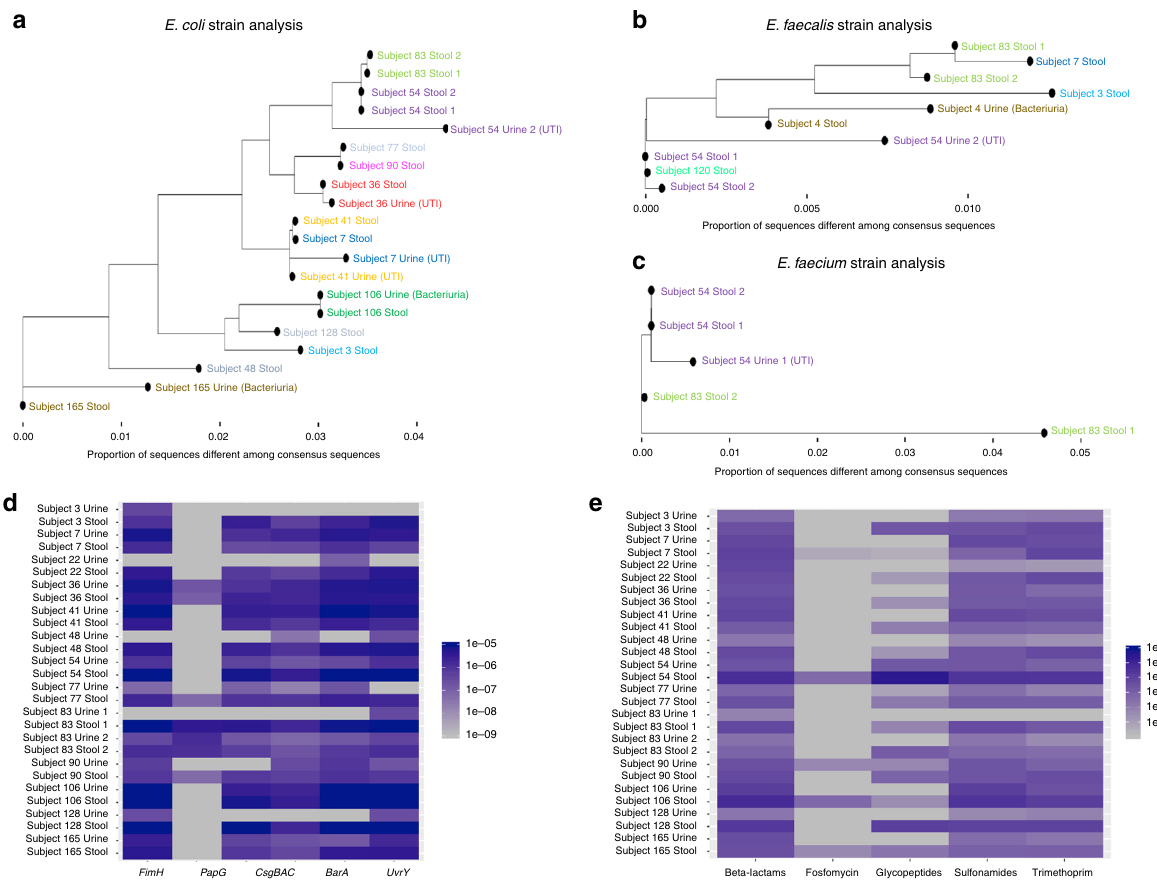
Fig. 2 Strain analysis, uropathogenic genes, and antimicrobial resistance genes in paired urine-fecal specimens. a Among 34 urine and fecal specimens pro fi led, 20 consensus strains for E. coli could be constructed using StrainPhlAn. A phylogenetic tree was constructed based on the E. coli strain alignment (24 markers) and the proportion of sequences that are different between strains is noted on the x -axis. Each point represents an E. coli strain from a urine or fecal specimen with different colors representing different subjects. b Among 34 urine and fecal specimens pro fi led, 10 consensus strains for E. faecalis could be constructed using StrainPhlAn. A phylogenetic tree was constructed based on the E. faecalis alignment (200 markers) and the proportion of sequences that are different between strains is noted on the x -axis. Each point represents an E. faecalis strain from a urine or fecal specimen with different colors representing different subjects. c Among 34 urine and fecal specimens pro fi led, 5 consensus strains for E. faecium could be constructed using StrainPhlAn. A phylogenetic tree was constructed based on the E. faecium alignment (200 markers) and the proportion of sequences that are different between strains is noted on the x -axis. Each point represents an E. faecium strain from a urine or fecal specimen with different colors representing different subjects. d Bacterial genes were determined using HUMAnN2 19 and relative abundance was estimated for each of the following uropathogenic E. coli associated genes: FimH , PapG , CsgBAC , BarA , and UvrY . A heatmap was constructed with the uropathogenic genes on the X -axis and the E. coli associated urine specimens and paired stool specimens on the Y- axis. The abundance is colored by blue intensity, log scaled. e Antibiotic resistance genes were determined using Bowtie2 21 on the MEGARES antibiotic resistance database 22 and RPKM was estimated for genes that confer resistance to beta-lactams, fosfomycin, glycopeptides, sulfonamides, and trimethoprim. A heatmap was constructed with antibiotic resistance gene classes on the X -axis and the E. coli associated urine specimens and paired stool specimens on the Y- axis. The abundance is colored by blue intensity, log scaled. Source data are provided as a source data fi